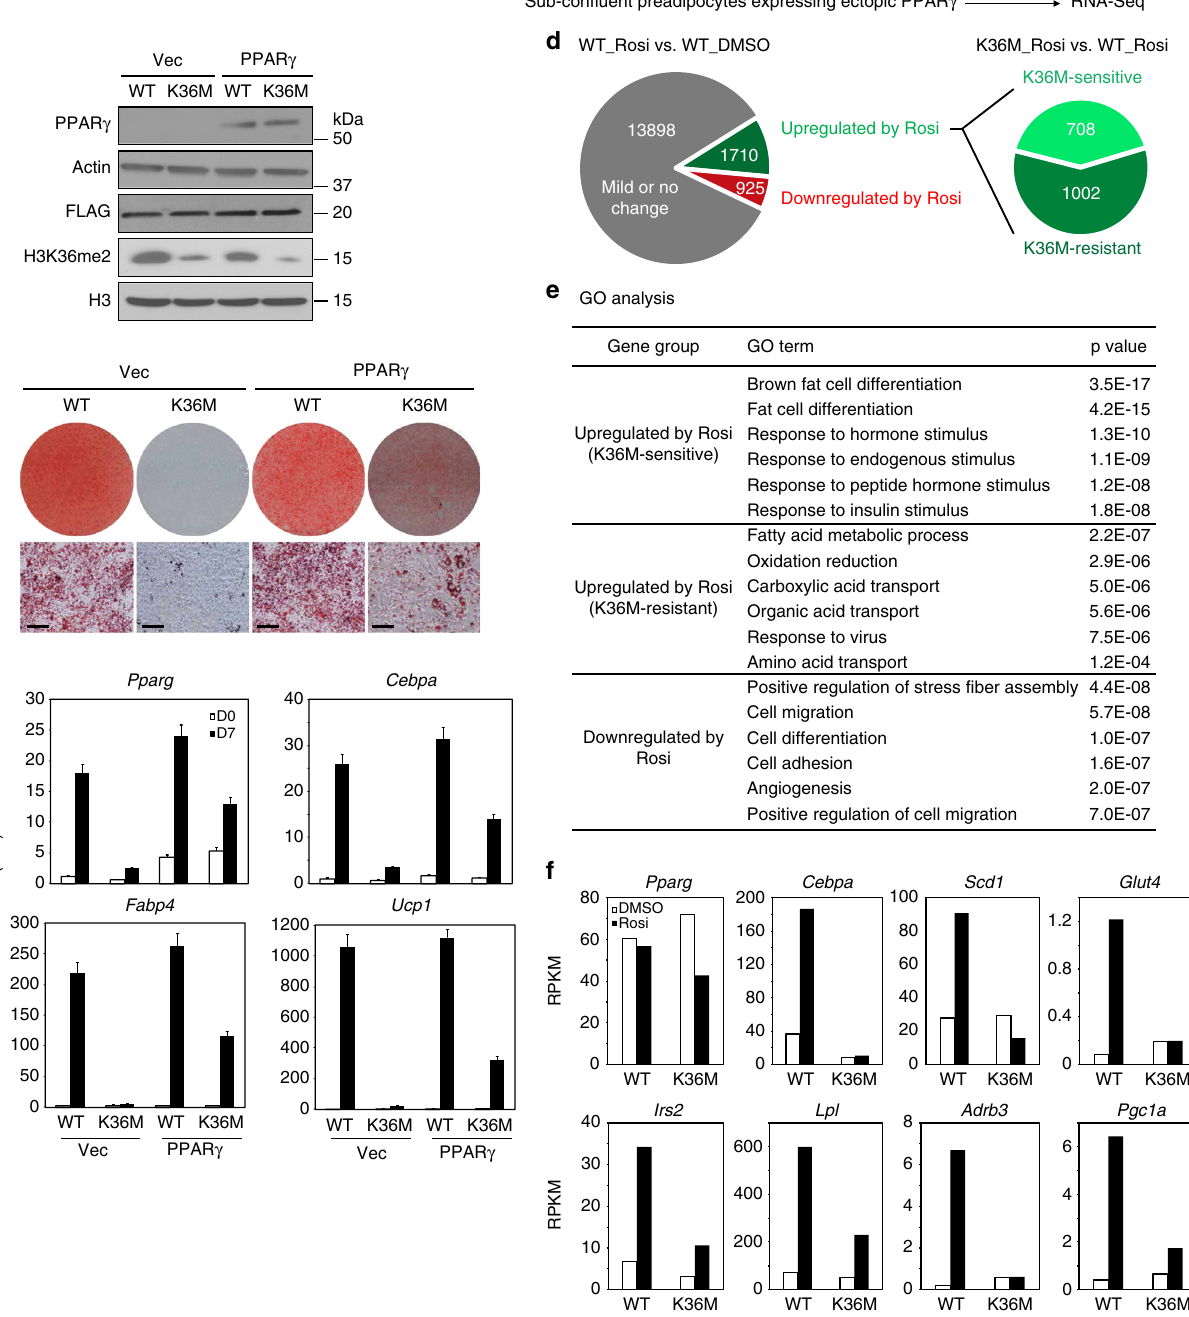
with 4-hydroxytamoxifen (4OHT) to delete the STOP cassette and induce H3.3K36M expression (Fig. 4e), followed by adipogenesis assay. Consistent with the data from LSL-K36M; Myf5-Cre mice, expression of H3.3K36M inhibited adipogenesis